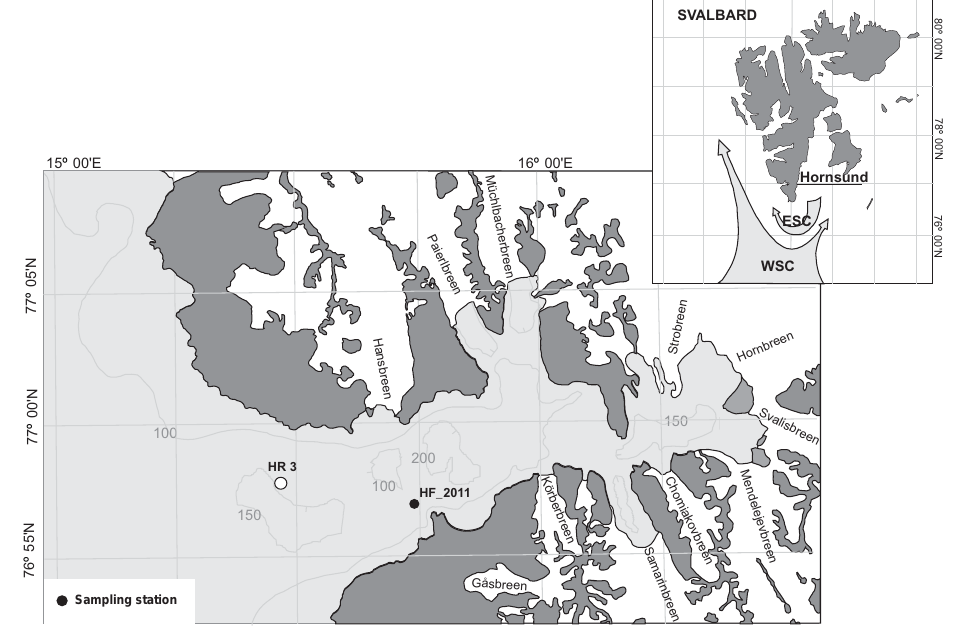
Figure 1. Bathymetric map of Hornsund with sampling station HF 2011. The position of core HR 3 studied by Majewski et al. (2009) is shown. Glaciers are shown in white. WSC – West Spitsbergen Current; ESC – East Spitsbergen